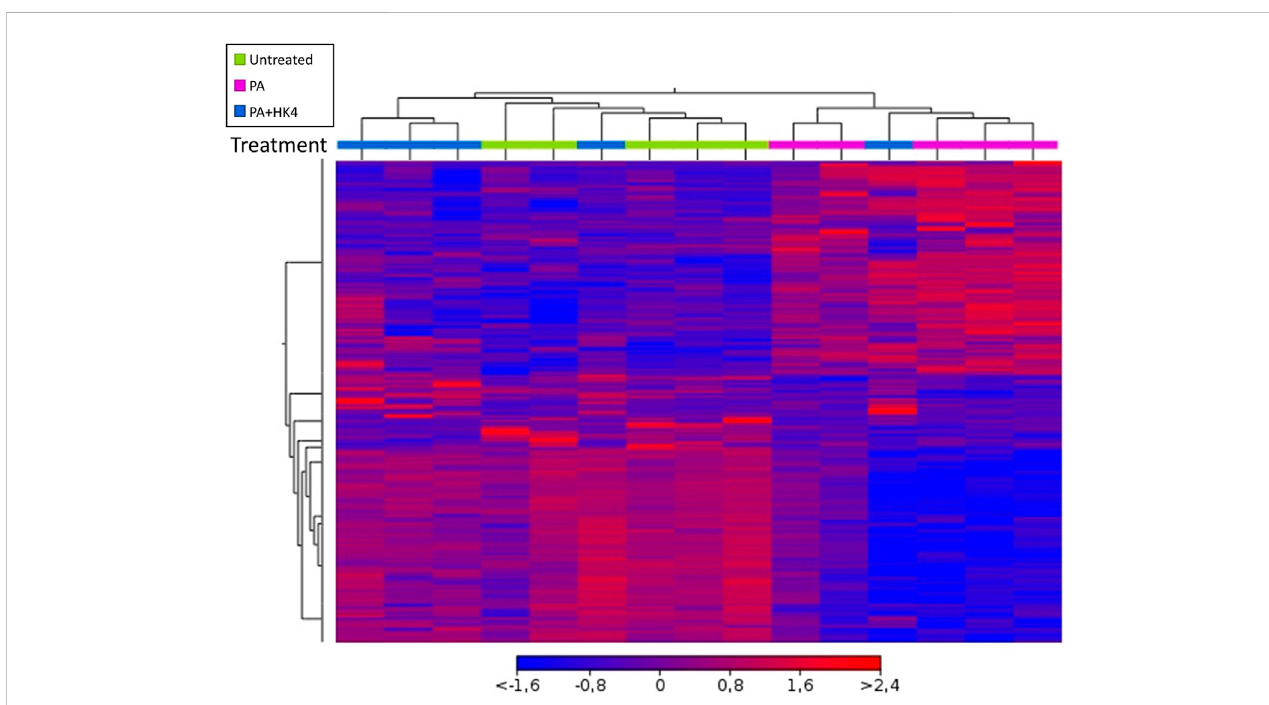
FIGURE 2 Overview of hierarchical clustering and heat map of transcription pro fi le of HepG2 cells in response to palmitate (PA, pink) and HK4 (blue) or untreated cells (green). Euclidean metric for distance measurement was used. Changes in the abundance of 1,570 individual genes are shown, while each rectangle represents a gene. The intensity of the red and blue colors correlates with the degree of up- and downregulation, respectively. Differentially expressed genes were de fi ned by ANOVA with a p -value ≤ 0.05 and an absolute fold change ≥